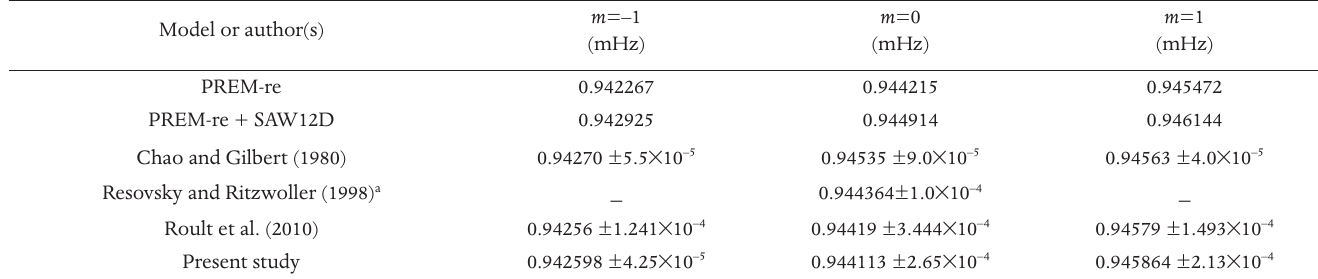
Table 1. Comparison of the observed triplet frequencies of